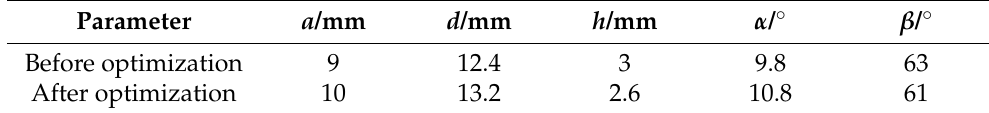
Table 11. Optimization factor parameters before and after optimization.